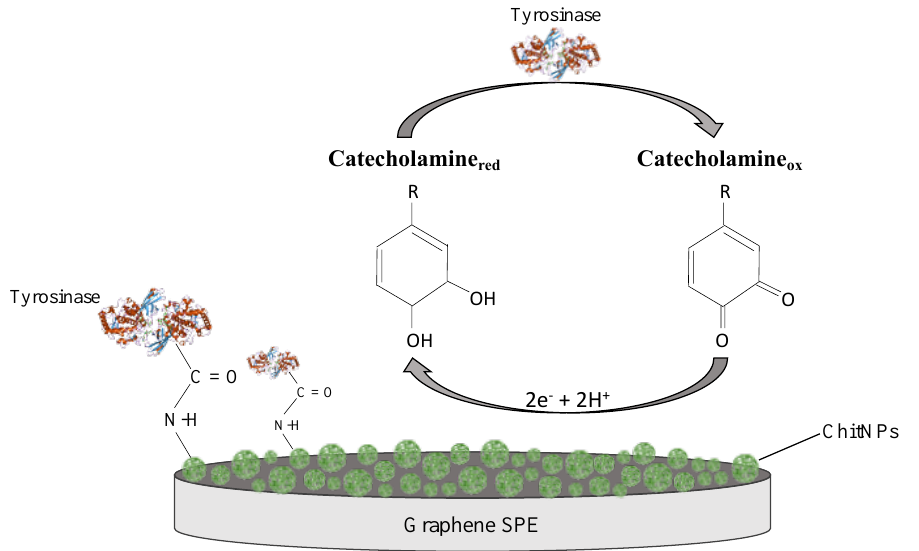
Scheme 1. Schematic representation of the Tyr/EDC-NHS/ChitNPs/GPH-SPE electrochemical platform and the CA biosensor mechanism.